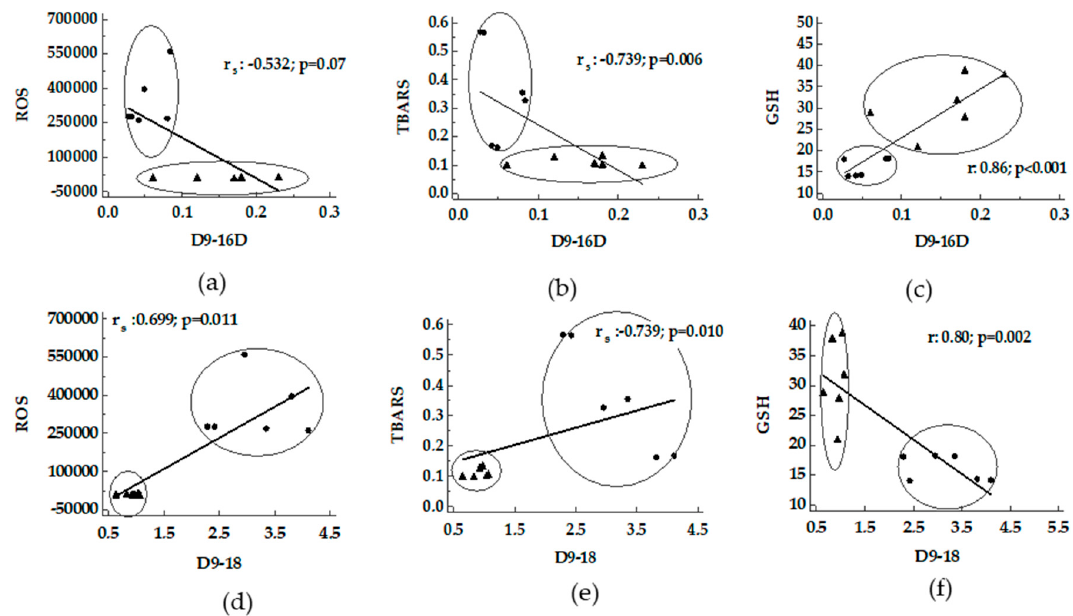
Figure 2. Correlation between desaturase activity indexes and oxidative stress in livers from MCD and Obese Zucker rats. Panels ( a – c ), D9-16D activity index versus ROS, TBARS and GSH; panels ( d – f ), D9-18D activity index versus ROS, TBARS and GSH. • : MCD rats; (cid:78) : Obese Zucker rats. TBARS, thiobarbituric acid reactive substances; ROS, reactive oxygen species; GSH, glutathione A negative correlation between DHA and ROS and TBARS supported by a positive correlation with GSH was detected (Figure 3).